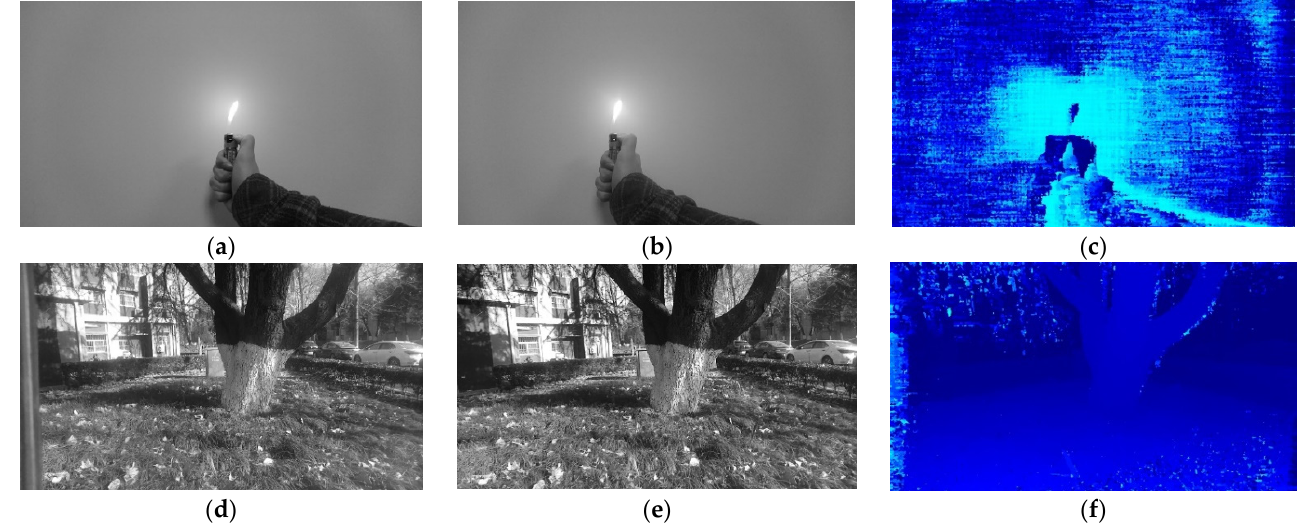
Figure 8. Display of disparity calculation results. ( a ) The left image of the flame. ( b ) The right image of the flame. ( c ) The disparity map of the flame. ( d ) The left image of the tree. ( e ) The right image of the tree. ( f ) The disparity map of the tree.